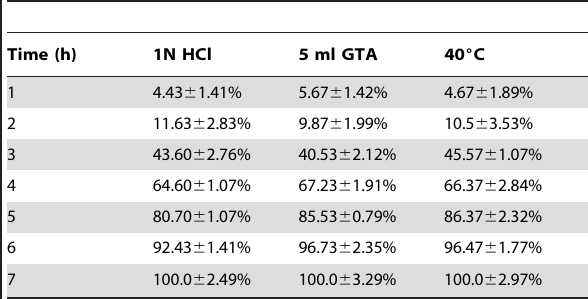
Table 5. Release behaviors of exenatide-load microspheres under optimized cross-linking conditions a .